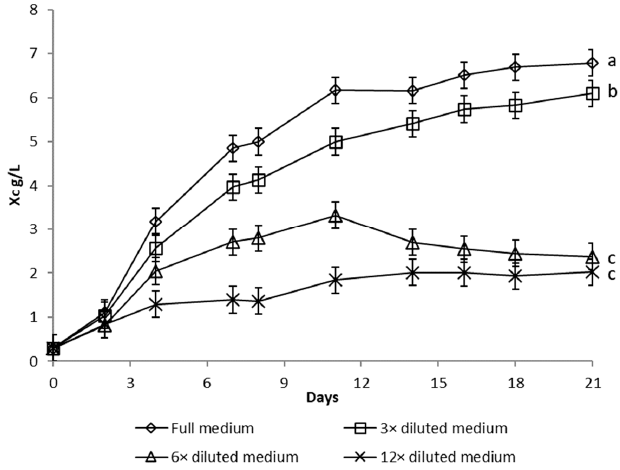
Figure 1. Microalgal cells dry weight (X C ) of Dictyosphaerium chlorelloides in full and nutrients limited media. Means with at least one letter the same are not significantly different ( p > 0.05). Comparison of statistical significance is presented for X C on the 21st day of cultivation. Error bars indicate the standard deviations. All experiments were carried out in three biological